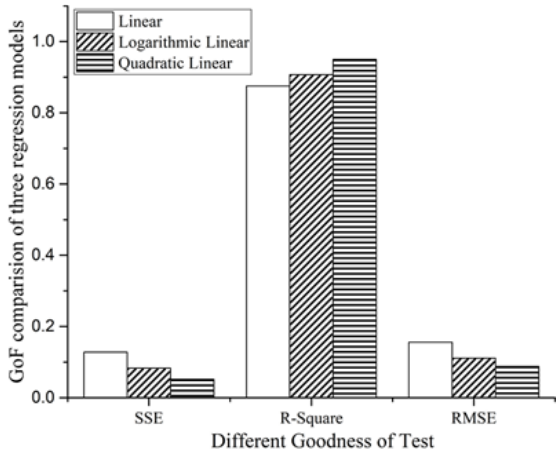
Figure 6. Different goodness of fit tests for the three